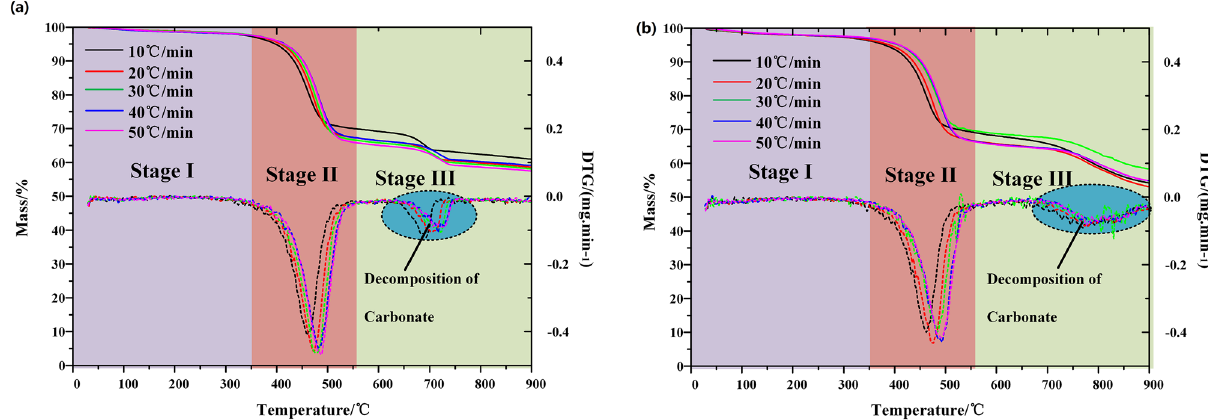
Figure 1. TG and DTG curve at ( a ) N 2 and ( b ) CO 2